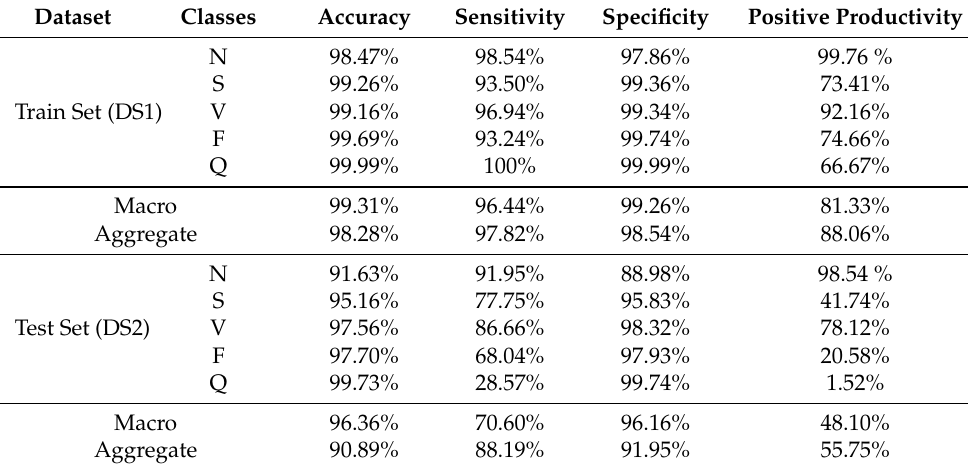
Table 7. Classification results for the inter-patient